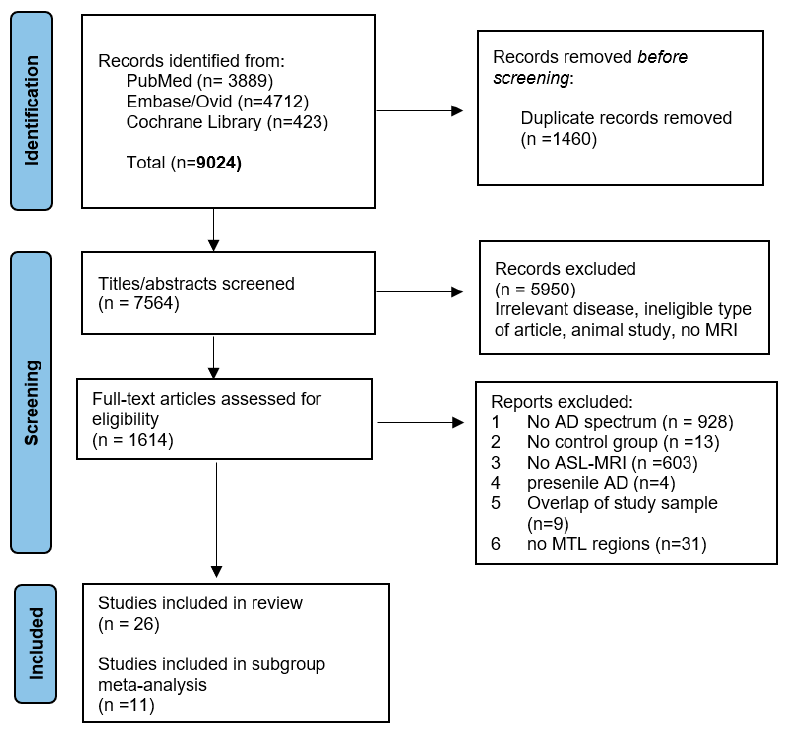
Figure 1. PRISMA flow diagram.